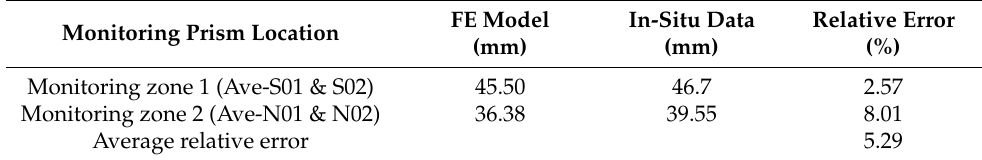
Table 2. In situ displacement and the FE model computed displacement.